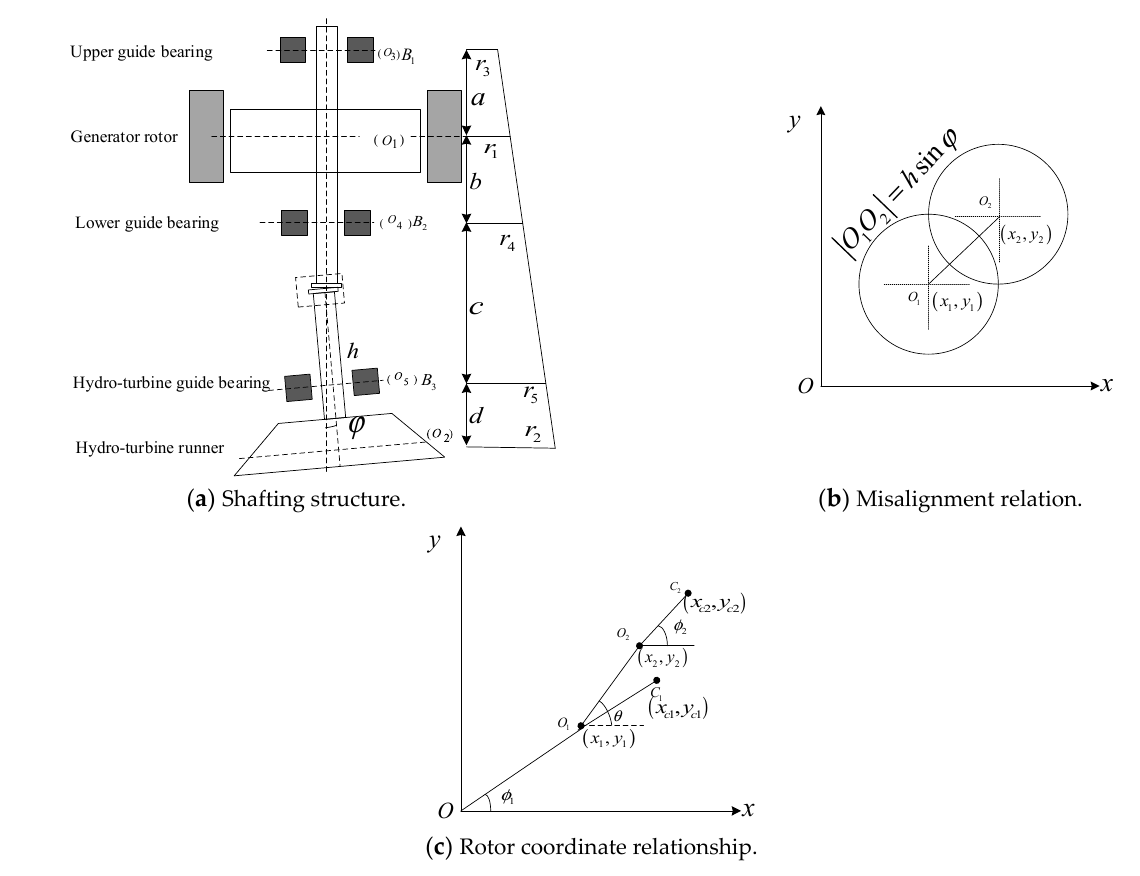
Figure 2. Misalignment shafting structure.